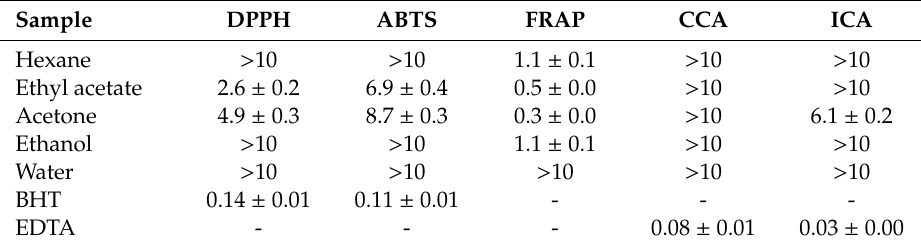
Table 6. Radical scavenging activity on the DPPH and ABTS radicals, ferric reducing antioxidant power (FRAP), and metal-chelating activity on copper (CCA) and iron (ICA) of organic and water extracts of Tetraselmis sp. CTP4. Results are expressed as the mean IC 50 (mg / mL) and corresponding standard deviation ( n =